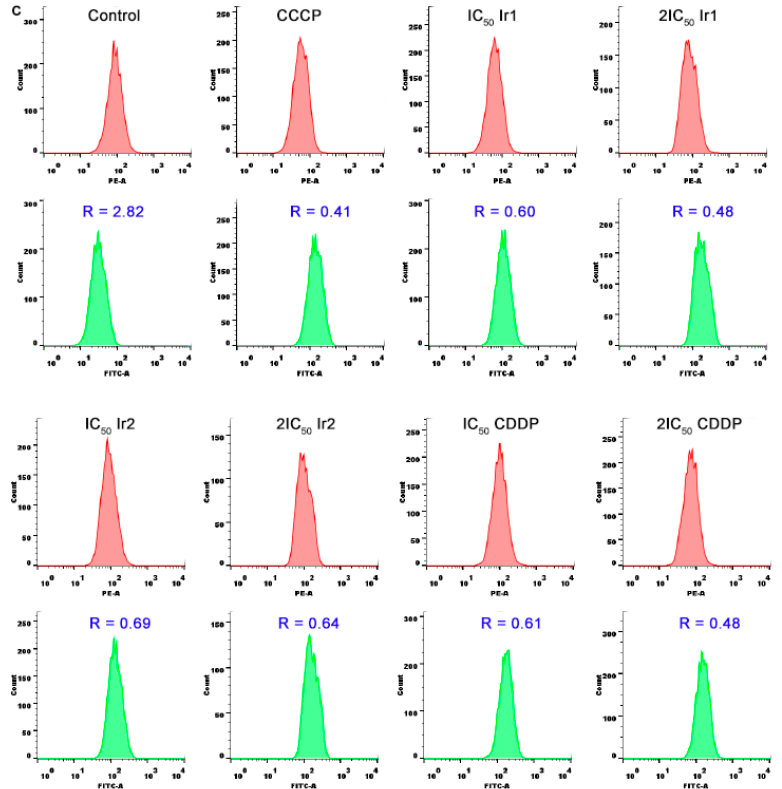
Figure 6. ( a ) The location of the complexes at the mitochondria after a 4 h exposure of HCT116 cells to IC 50 concentration of the complexes. ( b ) The assay of the change of mitochondrial membrane potential and ( c ) the ratio of red/green fluorescence after HCT116 cells were treated with IC 50 and 2IC 50 concentration of the complexes and cisplatin (CDDP) for 24 h.